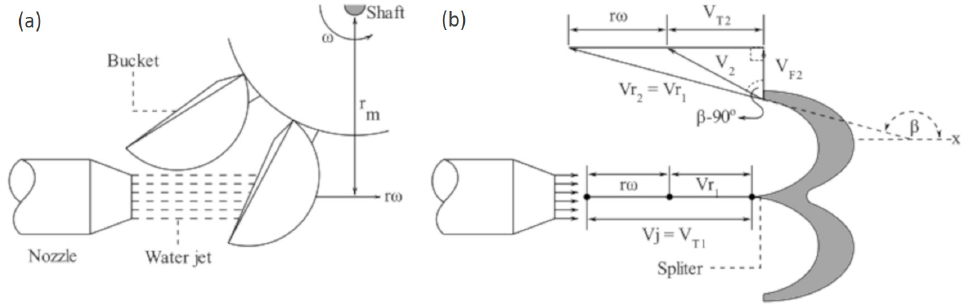
Figure 2. Pelton buckets schemes: ( a ) Fluid path in a bucket. ( b ) Velocity